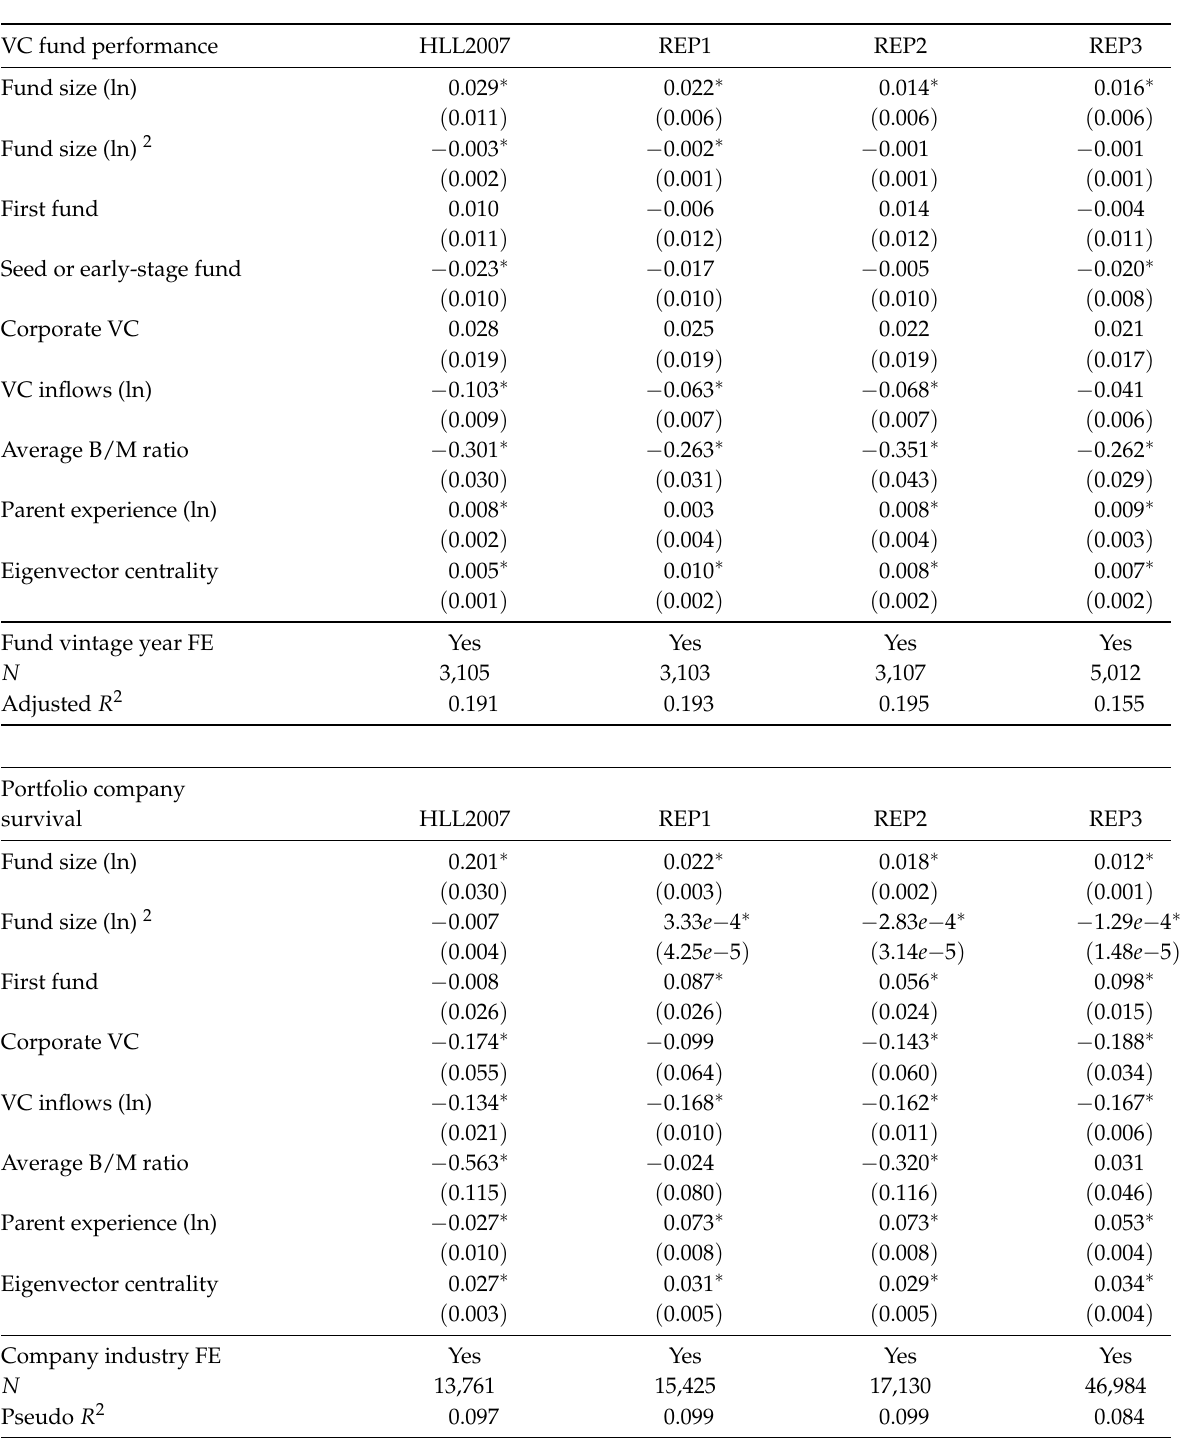
Table 2: VC fund performance and company